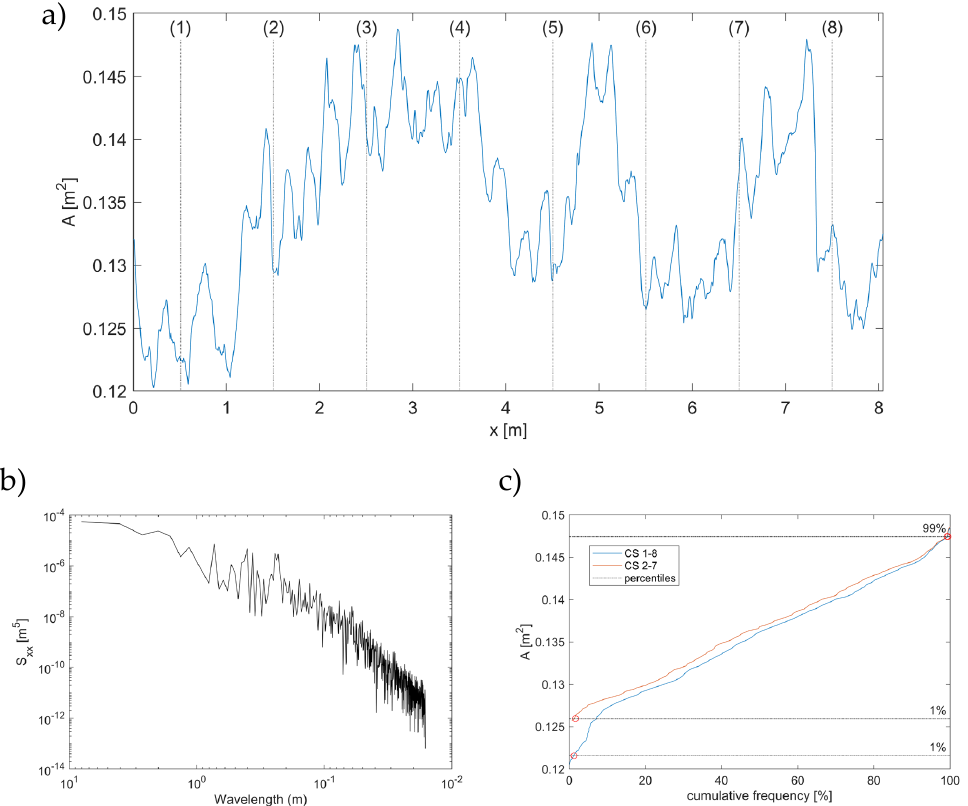
Figure 5. Variation of cross-sectional area along the model tunnel; the lines and numbers indicate the locations of the measurement cross sections ( a ); single-sided power spectrum S xx of the longitudinal profile of the cross-sectional areas ( b ); distribution curves of cross-sectional areas for the determination of A 1 and A 99 for the reaches from cross sections 1–8 and 2–7 ( c ). Table 2. Characteristic values derived from the distribution curves of the cross-sectional areas, standard deviation, skewness, and kurtosis for reaches 1–8 and 2–7 (in model scale).